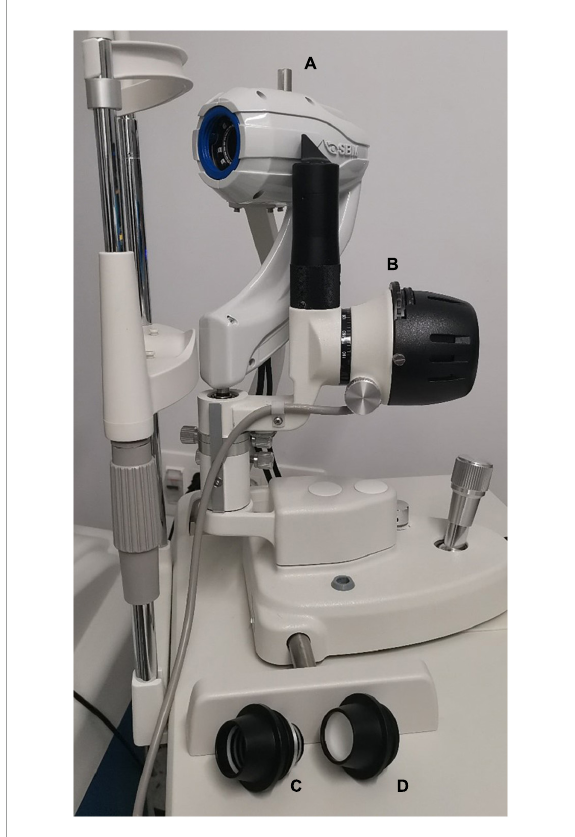
FIGURE1 Ocular Surface Analyzer (OSA) device fit in a slit lamp tonometer hall. (A) OSA measurement head device. (B) Slit lamp illumination system. (C) Placido grid measurement cone. (D) Plain measurement